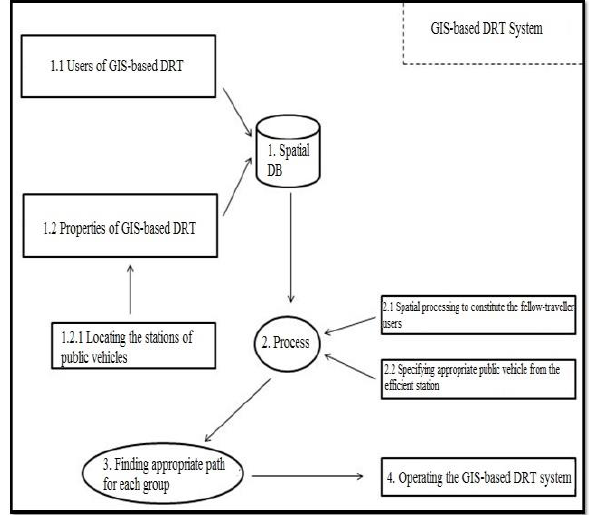
Figure 1. GIS-based DRT